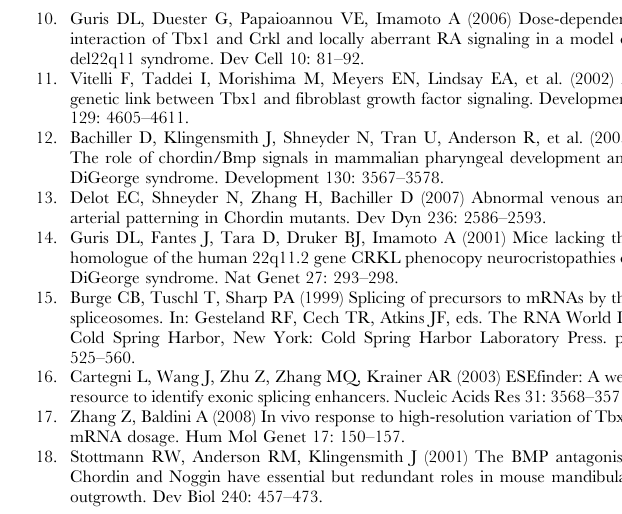
Figure S1 Absence of Tbx1 results in phenotypes identical to Chrd null homozygotes in a 129S6 inbred genetic background.